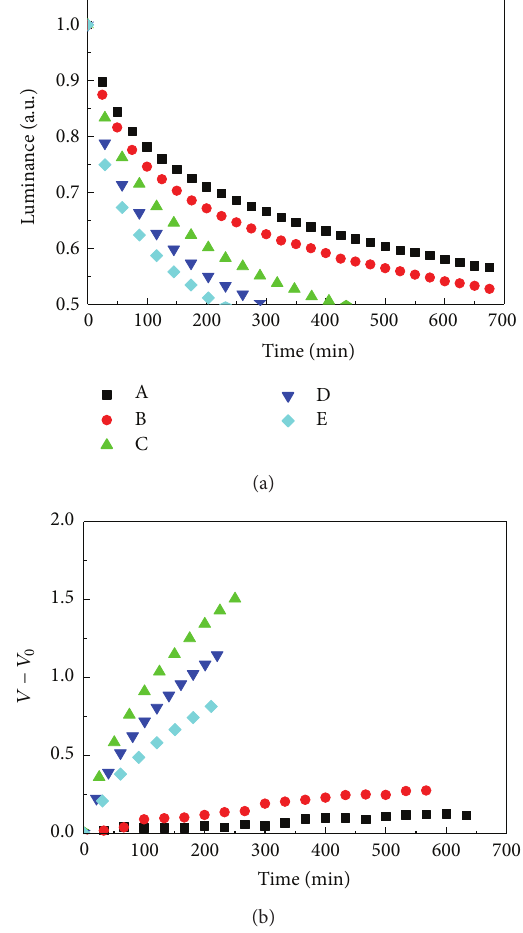
Figure 3: (a) Normalized luminance ( 𝐿 ∗ ) and (b) voltage variation ( 𝑉 - 𝑉 0 ) versus operating time of five types of OLED structure. The last 5 nm Bebq 2 layer prepared with a two-step process (device A, 0.03 nm/s and device B, 0.3 nm/s) on bulk Bebq 2 (55nm and 1.3 nm/s).The reference devices were used at the constant deposition rates of 1.3 (device C), 0.3 (device D), and 0.03 (device E) nm/s in bulk Bebq 2 EML/ETL (60 nm). All devices were driven with constant current density of 100 mA/cm 2